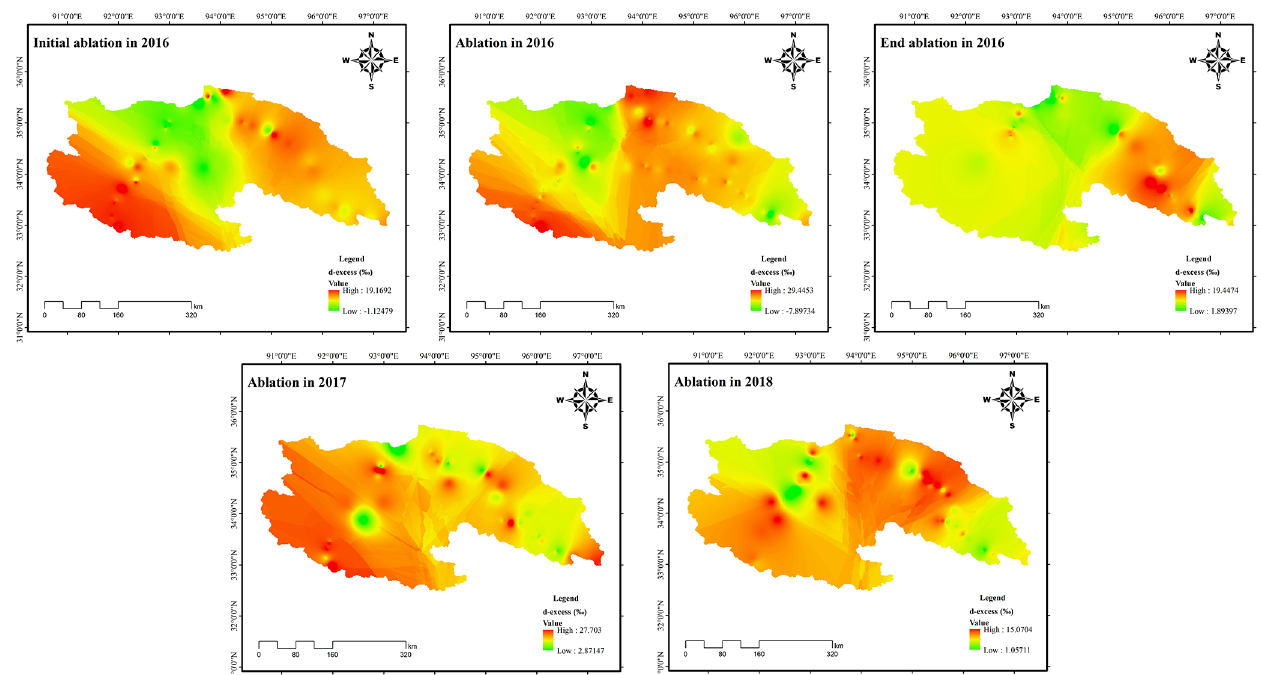
Figure 4. Spatial variation in d -excess based on different ablation in 2016 and ablation from 2016 to